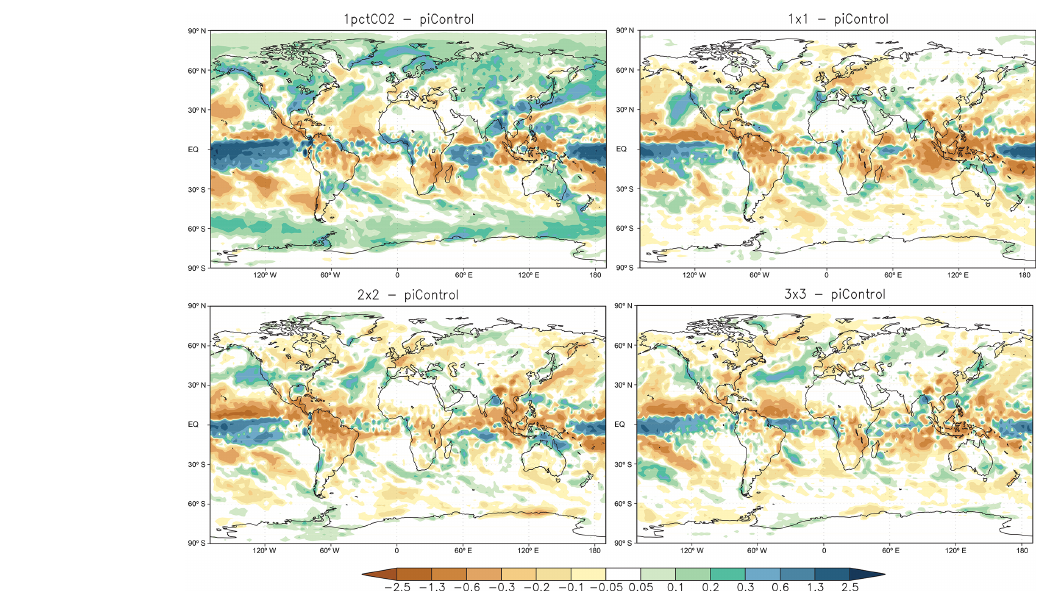
Figure 23. Same as Fig. 20 but for GISS ModelE2 (the evaluation